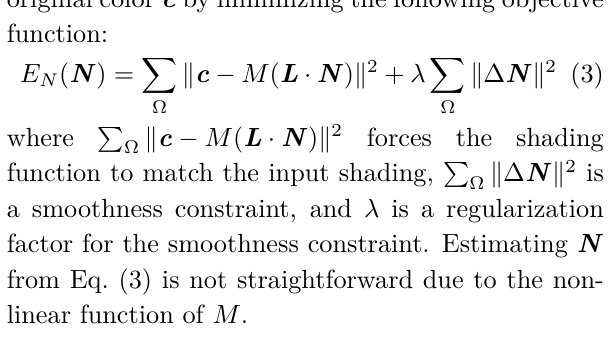
Fig. 7 Illumination constraints for normal refinement. The initial illumination result is modified by luminance range constraints derived from M − 1